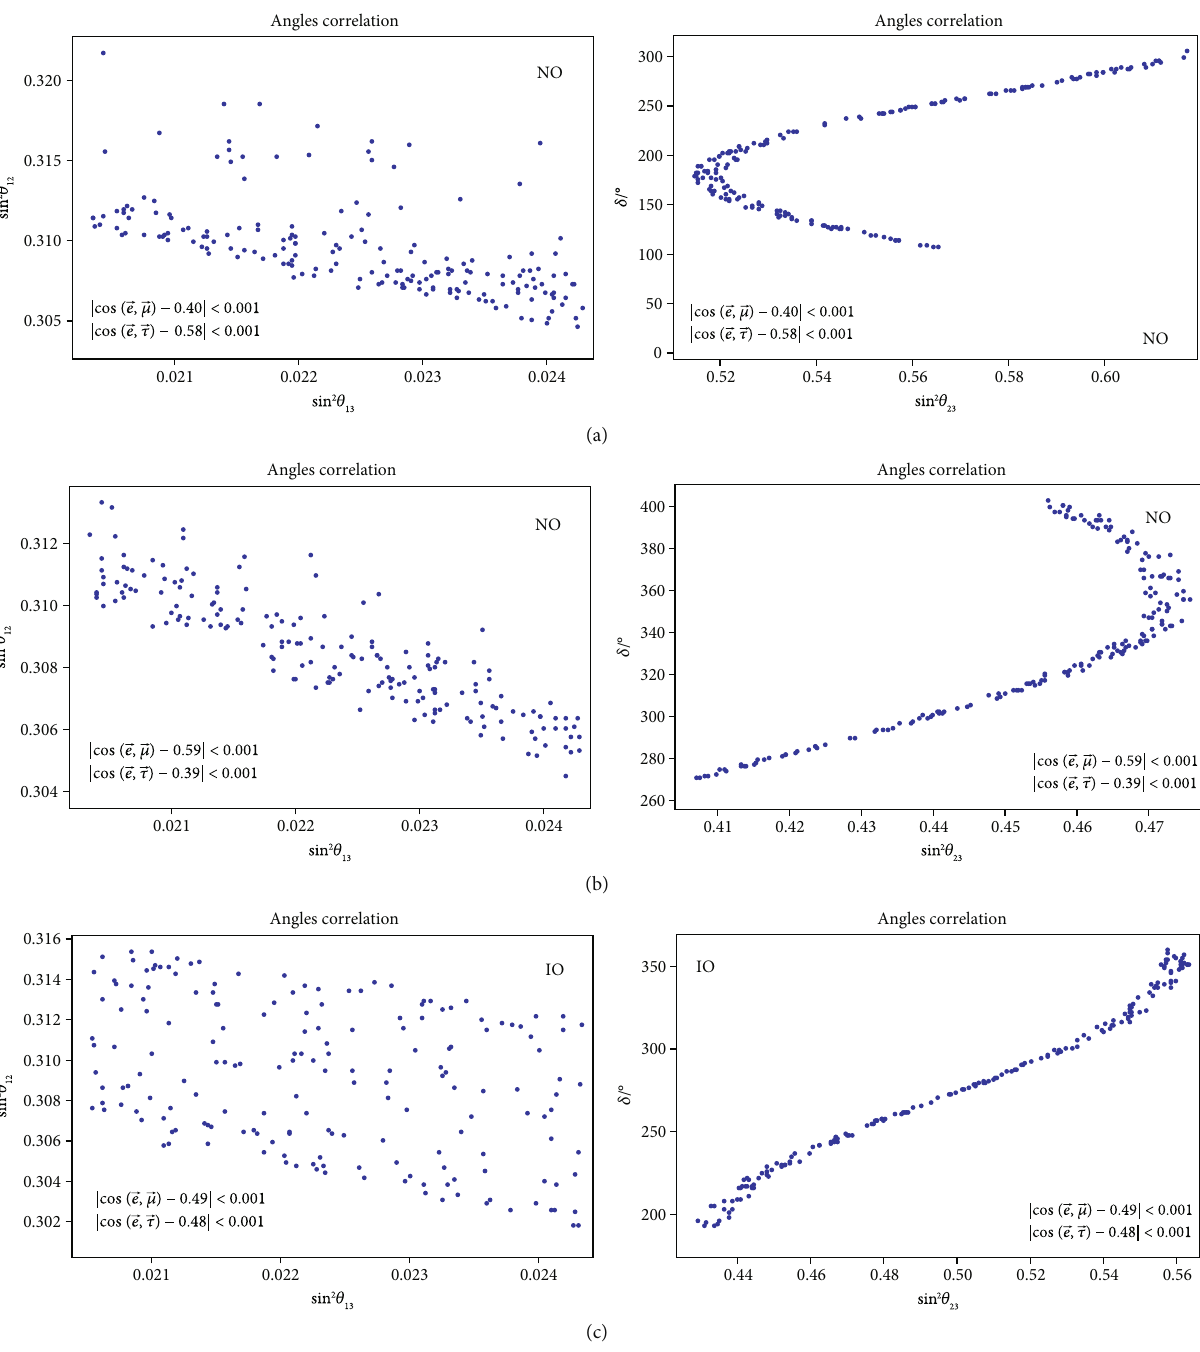
Figure 9: Leptonic mixing parameters constrained by the correlations between two included angles of ( cos ð e Table 4. (a) NO case with the constraints of j cos ð e ! ! Þ − of j cos ð e , μ 0 : 59 j < 0 : 001 and j cos ð e − 0 : 48 j < 0 : 001